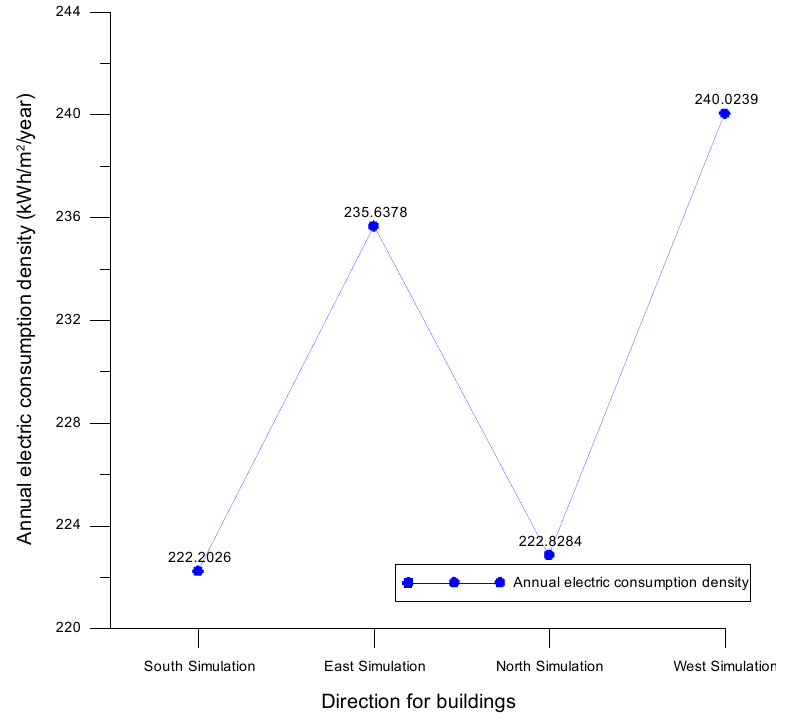
Figure 4. Comparison of the annual energy consumption densities for different building orientations.